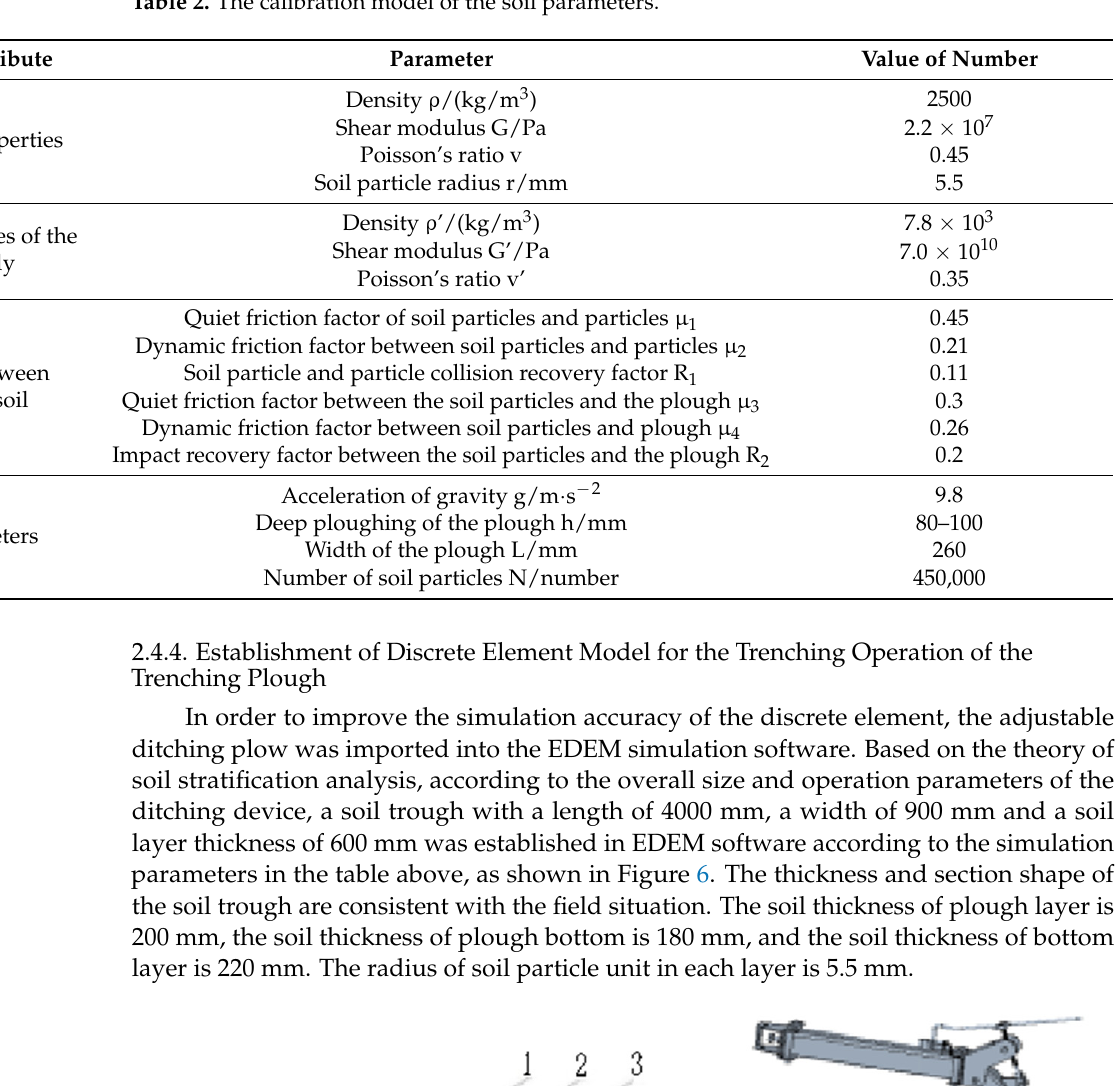
Table 2. The calibration model of the soil parameters.